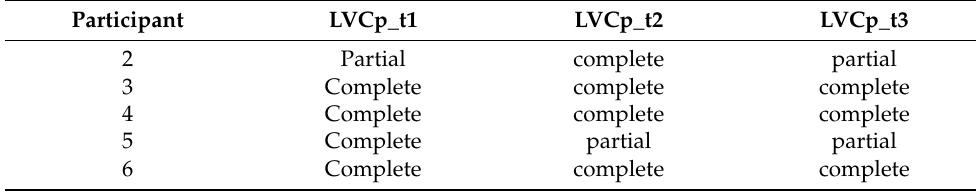
Table 31. LVC, pudding 10 mL, individual descriptions at three assessment time